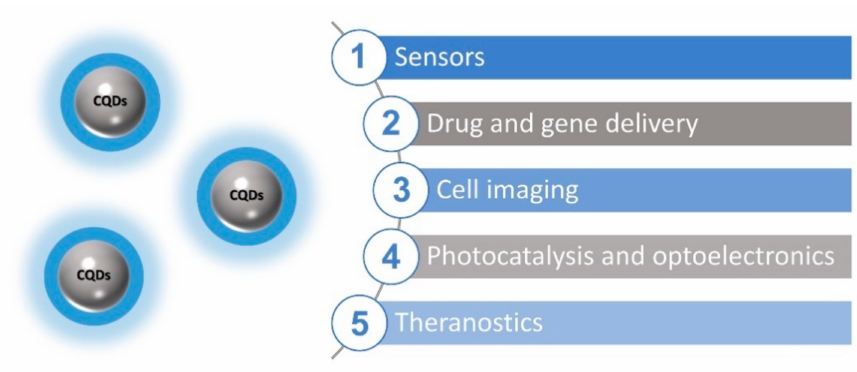
Figure 1. Potential applications of